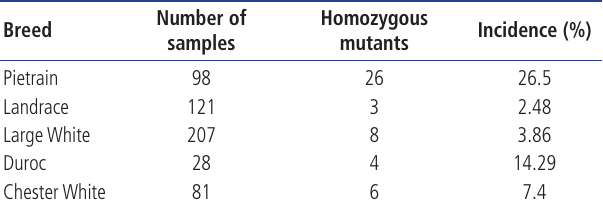
Table 2. Incidence of homozygous mutants in BAX gene associated with scrotal hernia among different breeds Breed